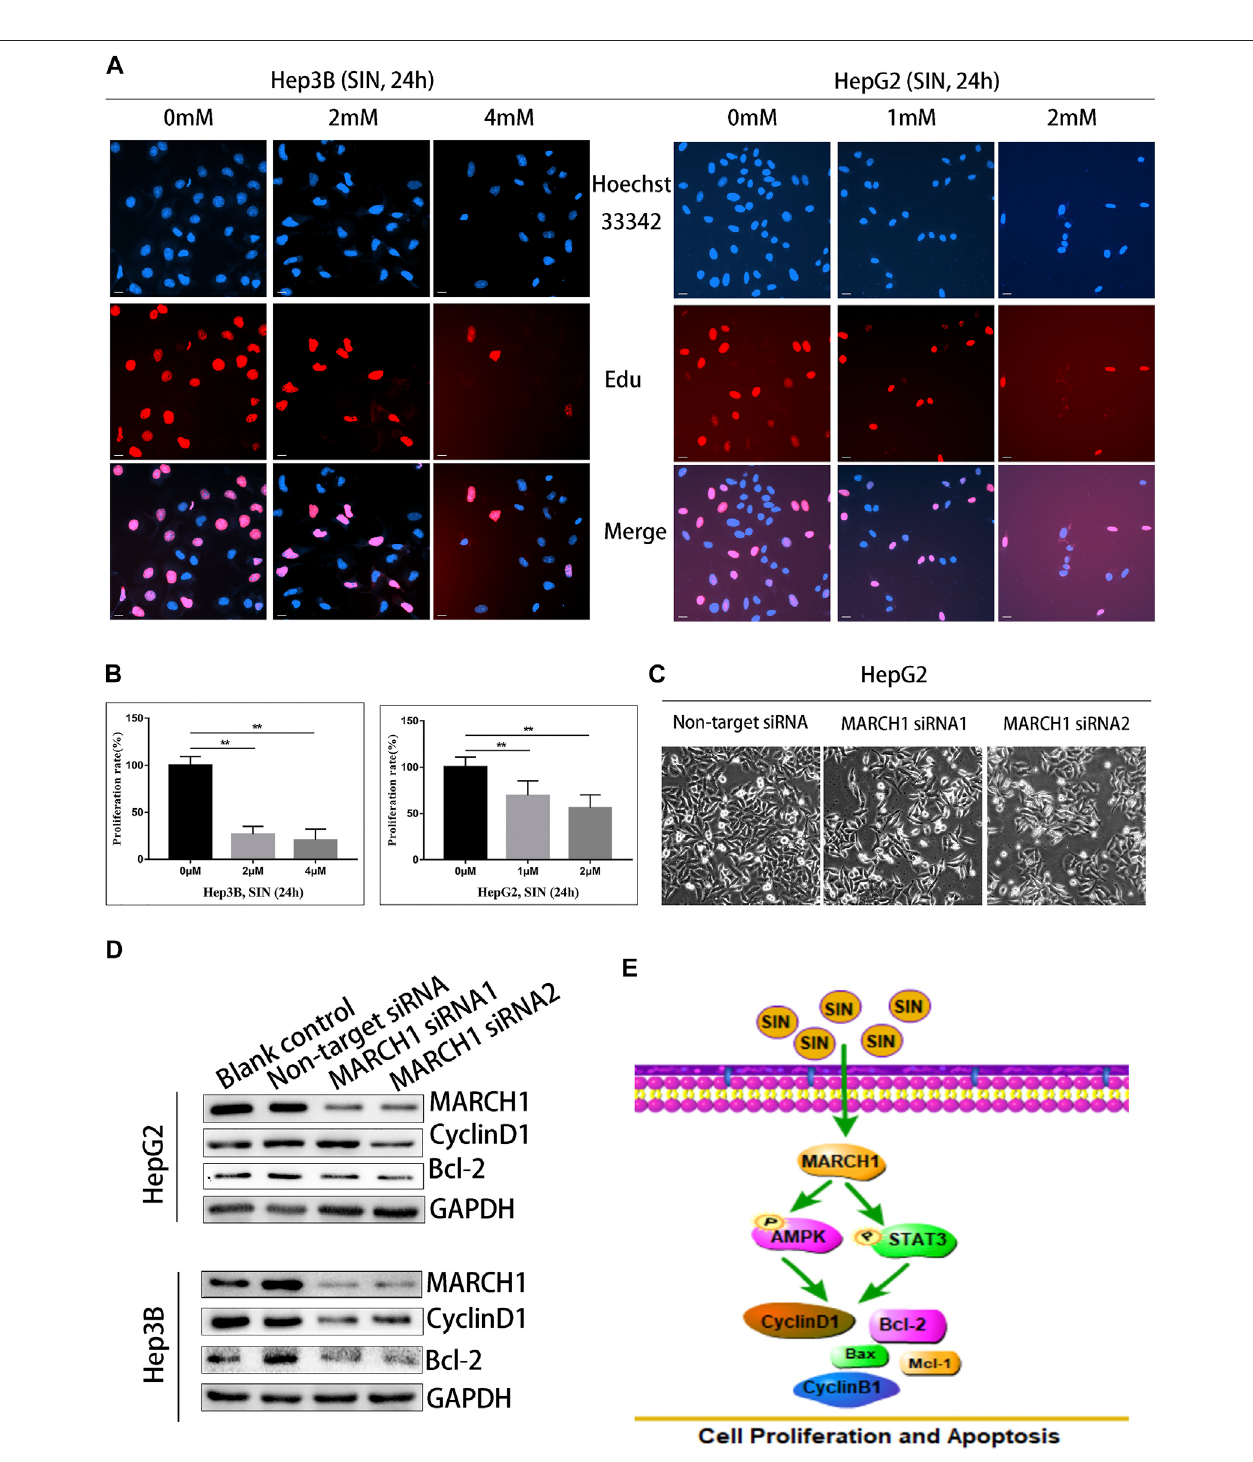
FIGURE5| SINsuppressedtheproliferationofHCCcellsbyinhibitingMARCH1. (A) TheEdUassay.TheHep3BandHepG2cellsweretreatedwithSIN(Hep3B:0, 2,4 mM HepG2:0,1,2 mM)for24 h.Thenumber ofproliferativenucleiwerecounted. Bar, 20 μ m. 0 mMascontrol. (B) Thestatisticalgraphsofdifferentconcentration of SIN on HCC cells inhibition. (C) The morphology of cells after silencing MARCH1 in HepG2 cells. (D) The expression of CyclinD1 and Bcl-2 detected after MARCH1 knockdown using siRNA in Hep3B and HepG2 cells. (E) The schemm shows that SIN regulates MARCH1-mediated AMPK/STAT3 signaling to affect cell proliferation and apoptosis. All data are means ± SD of results from three experiments. ** represents p < 0.01.